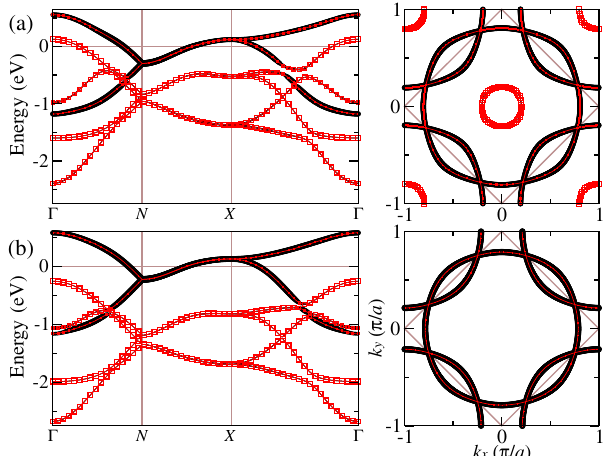
FIG. 2. The band dispersions and the corresponding FS of (a) the noninteracting U ¼ 0 and (b) the nonmagnetic state in the interacting ð U; J Þ ¼ ð 1 . 2 ; 0 . 05 Þ eV system at x ¼ 0 . The thick- ness of the black lines denotes the content of the J doublet, while the size of the red open squares shows the content ¼ 3 = 2 multiplet. of the J eff